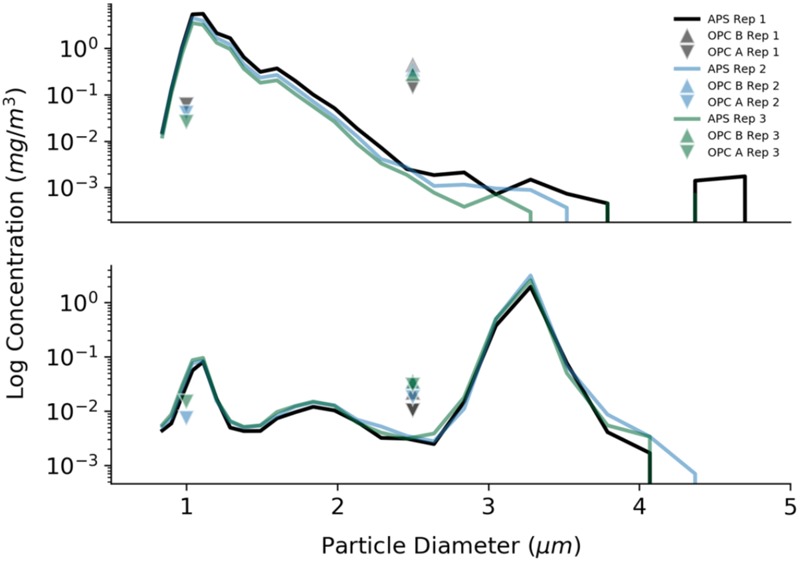
Laboratory tests to determine the accuracy of the optical particle counters used in this study. Results are presented for three repetitions of two different trials. The log of the particle concentration for 1 μm beads (trial 1, Top) and 3 μm beads (trial 5, Bottom) from the APS is compared to the readings from the two different optical particle counters (OPCA and OPCB).